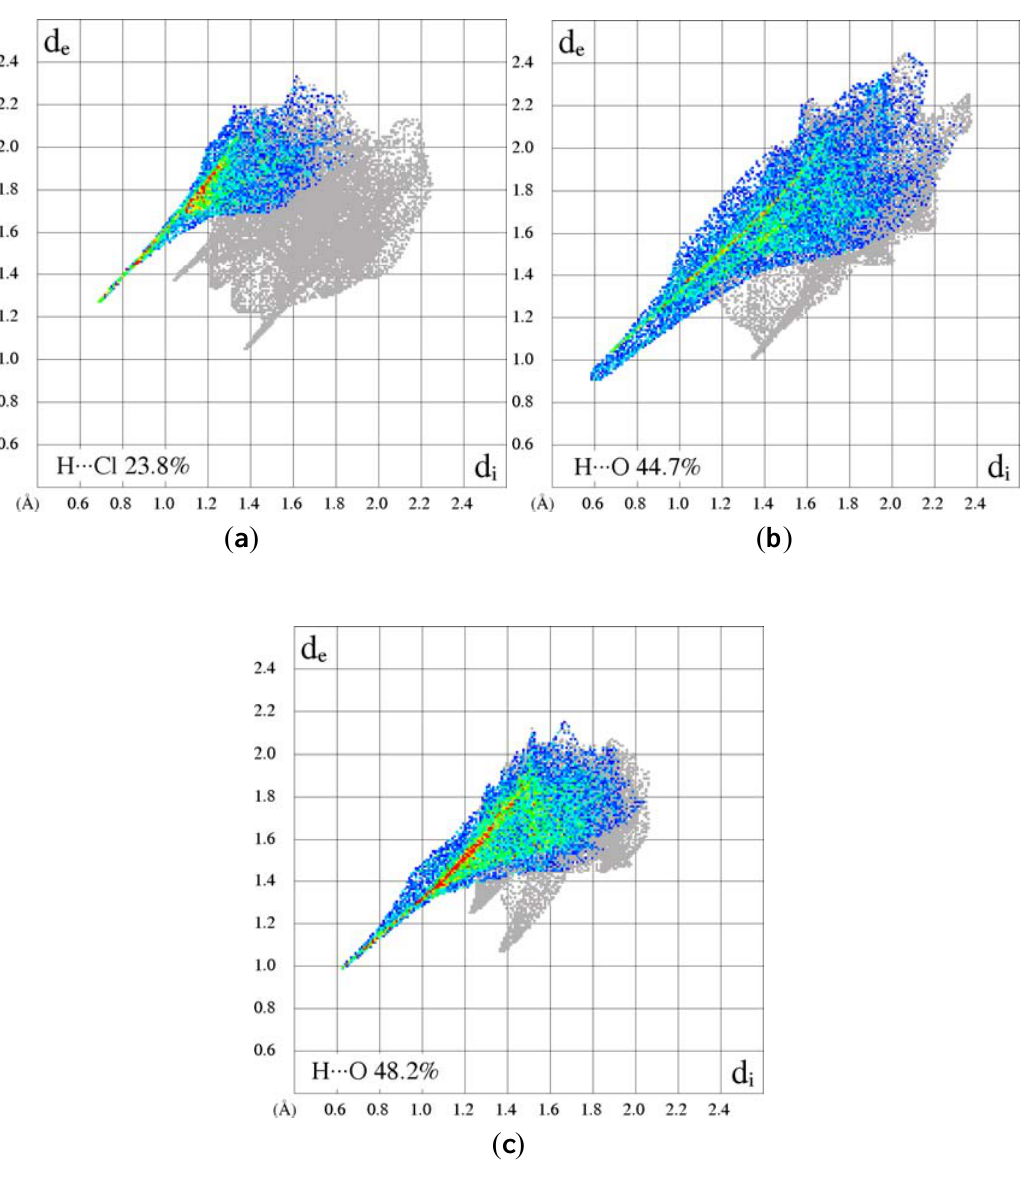
Figure 7. Two-Dimensional fingerprint plots of ( a ) 1-hydroxyimidazole hydrochloride; ( b )